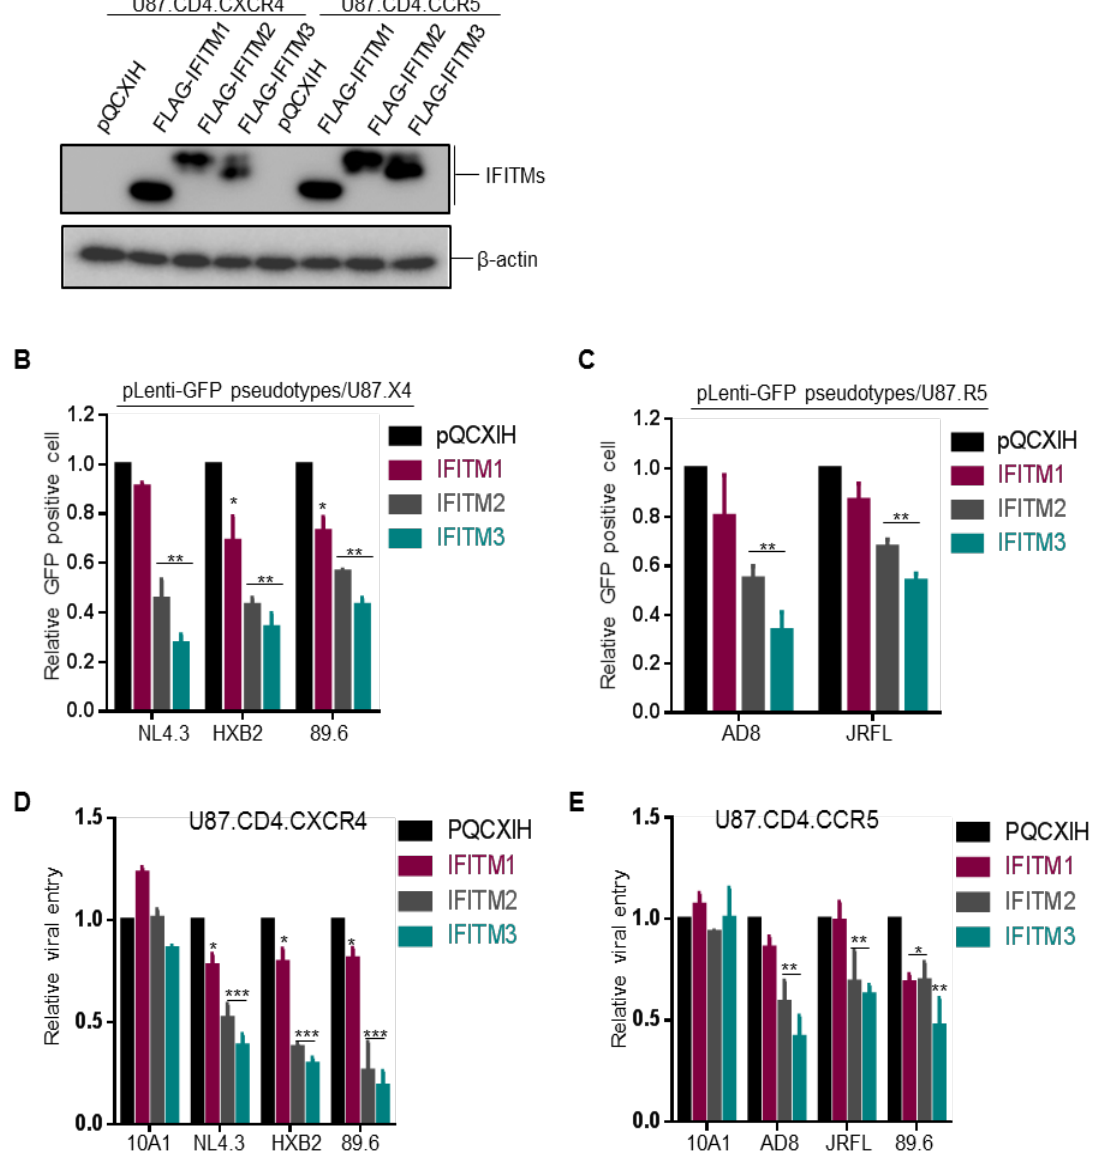
Figure 1. Ectopic expression of IFITM proteins inhibits entry of HIV-1 CXCR4 (X4) and CCR5 (R5) strains at equivalent efficiency independent of co-receptor usage. ( A ) FLAG-tagged IFITM1, 2, 3 expression levels in U87.CD4.CXCR4 and U87.CD4.CCR5 stable cell lines were examined